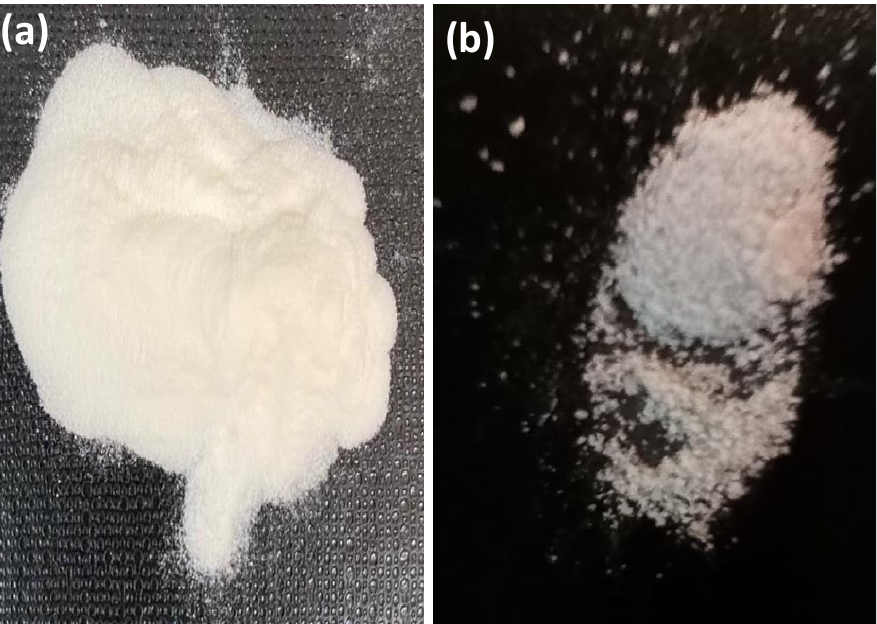
Figure 1. Macro images for the raw material powder used in this work ( a ) acrylic resin powder of artificial teeth and ( b ) ZrO 2 powder.